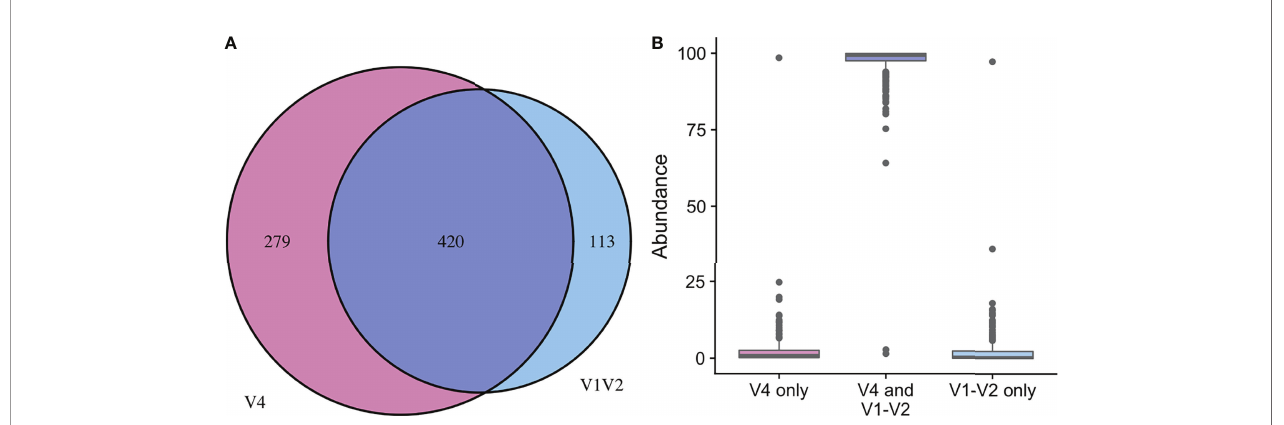
FIGURE 4 | Comparison of taxa recovered from different sequencing amplicons. For samples with classi fi ed taxa from both V1-V2 and V4 regions (n=164), paired ASV tables were compared. (A) shows that 113 unique genera were identi fi ed with the V1-V2 region, 279 unique genera were identi fi ed with the V4 region, while 420 genera were shared and identi fi ed with both regions. (B) shows the relative sequence abundances of those identi fi ed with each region, as well as those that were identi fi ed with both regions. The unique genera that are only identi fi ed with one region are extremely low abundance sequences with an occasional outlier, while the large majority of the highly abundant sequences were identi fi ed in both regions (i.e., V1-V2 and V4 regions).